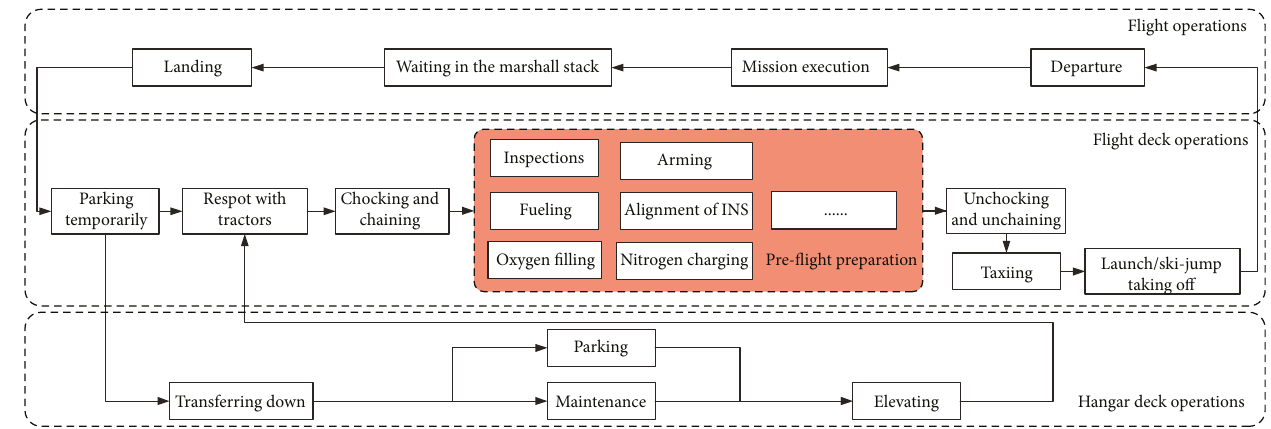
Figure 1: The procedure of aircraft carrier